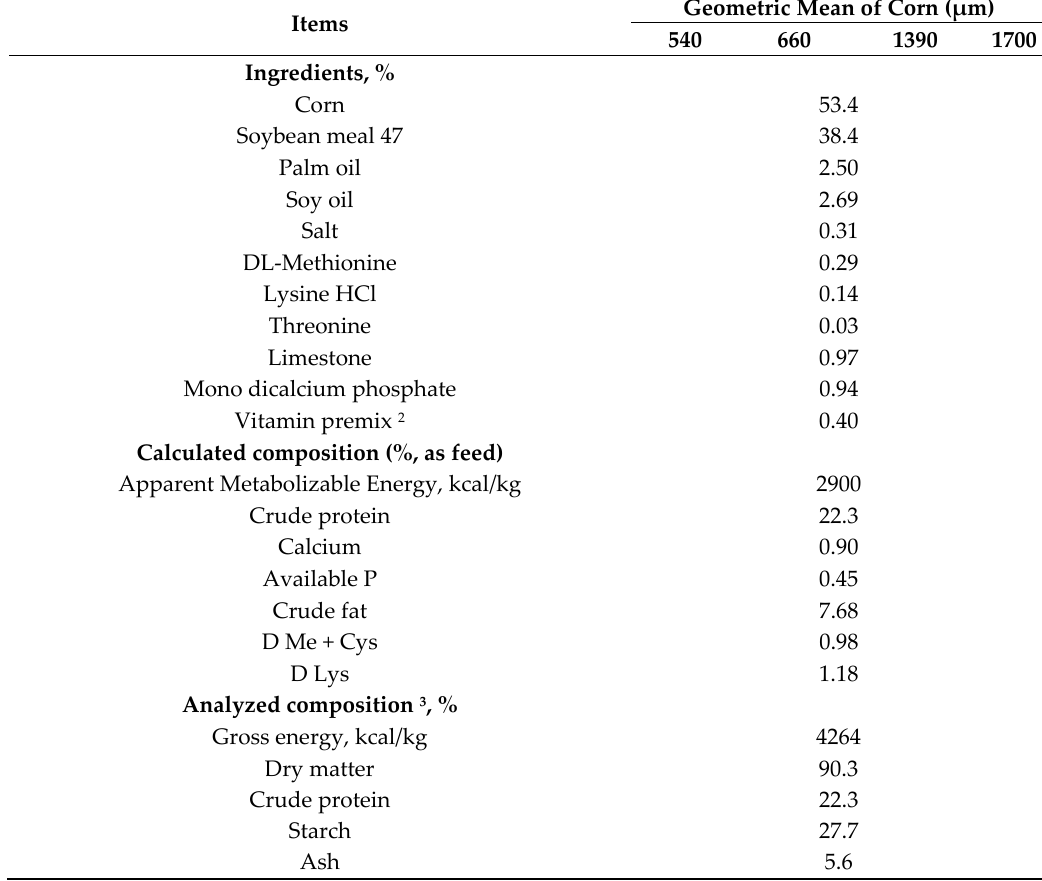
Table 1. Ingredient and calculated composition of the d 0 to 21 experimental diets 1